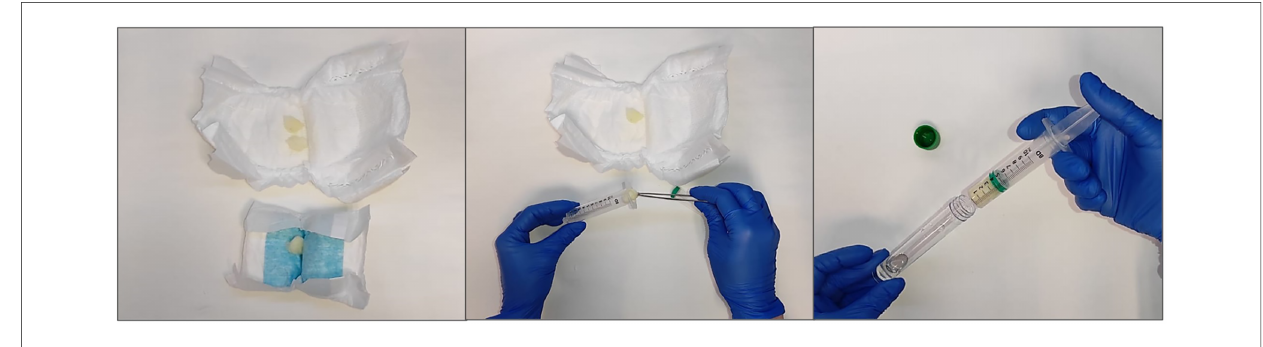
FIGURE 2 Infants ’ urine sample collection procedure. Sterile cotton pads are placed in the diaper (left); cotton pads soaked with urine are collected using sterile tweezers (middle); cotton pads are squeezed with a sterile syringe to collect the urine sample